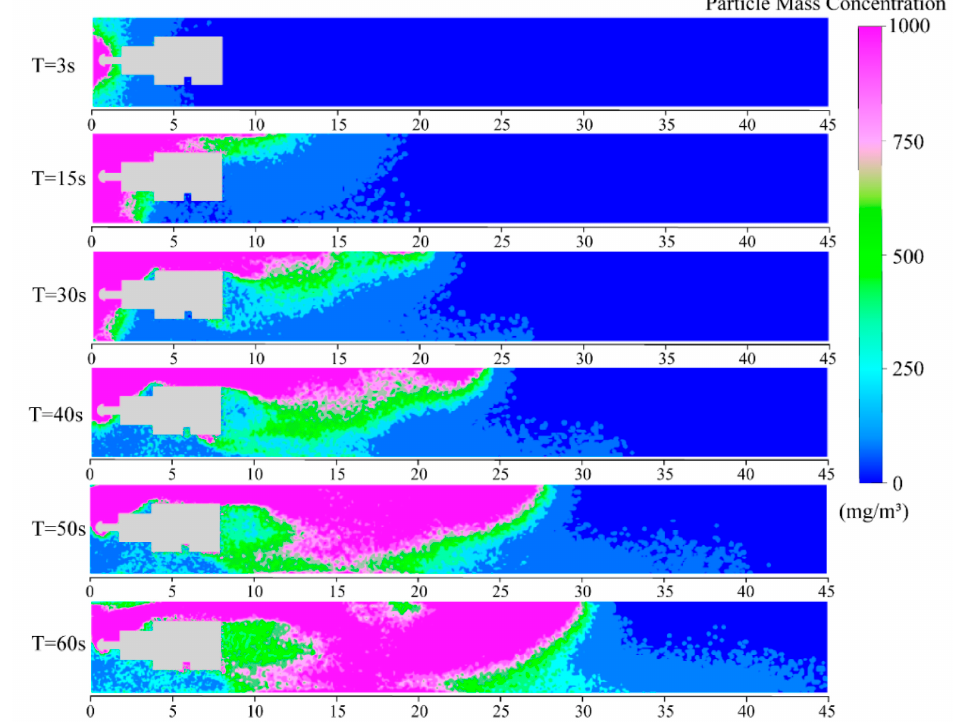
Figure 16. Simulation results of dust diffusion in the 1.5 m breathing zone (standard tunneling model).